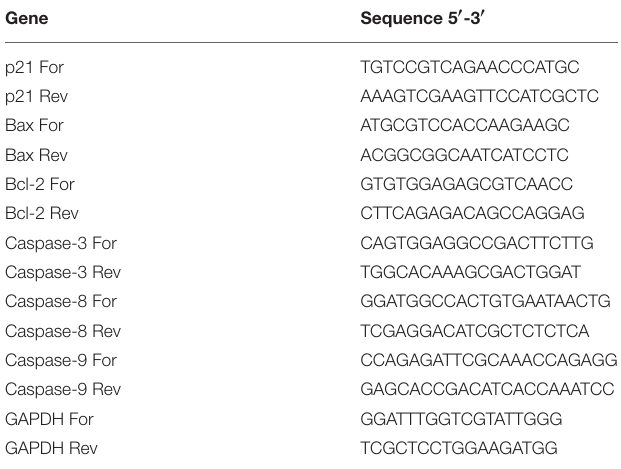
TABLE 1 | Primers sequences used in this study.